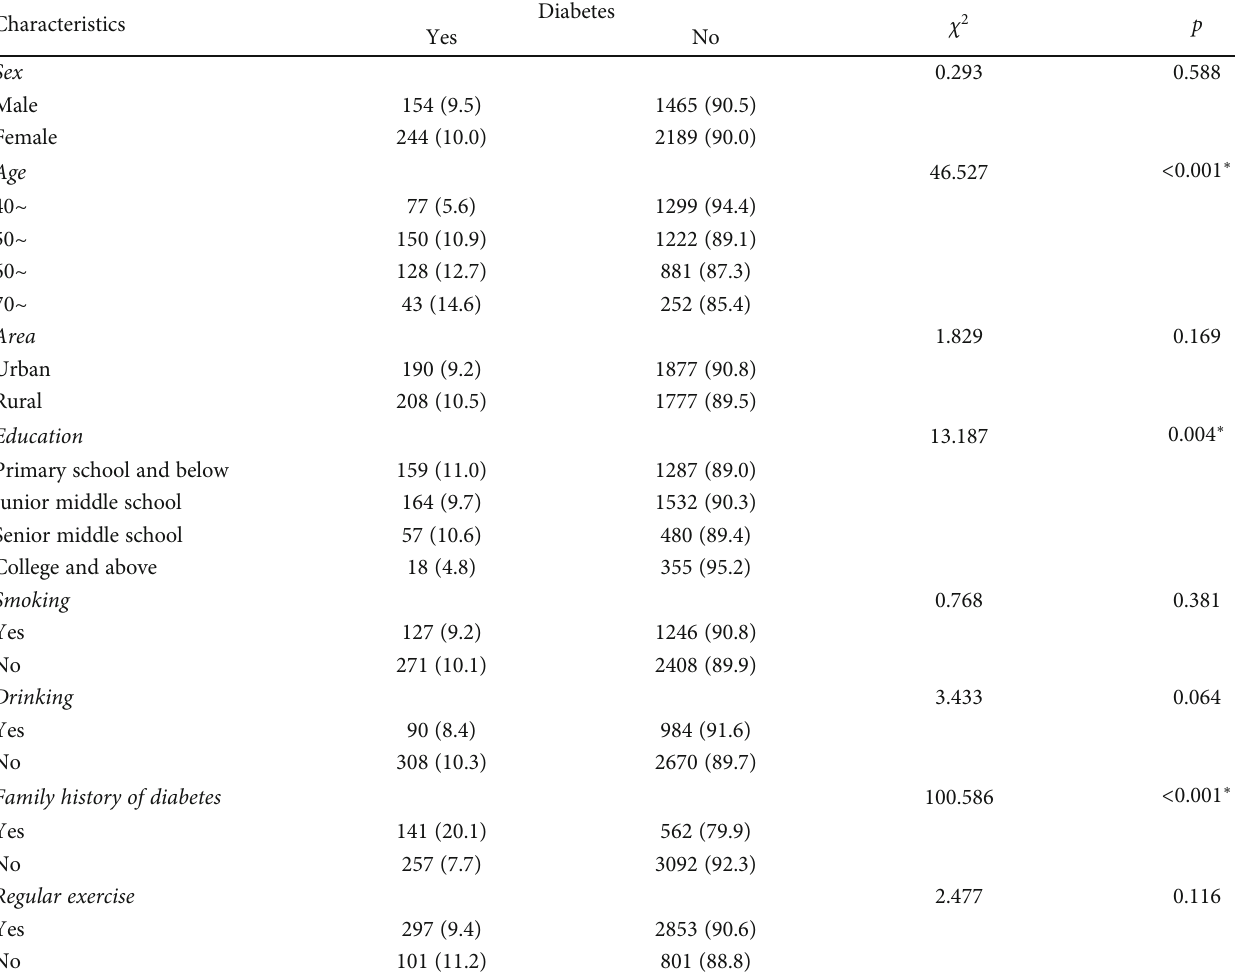
Table 1: Characteristics of the included participants aged 40 years or older ( n = 4052